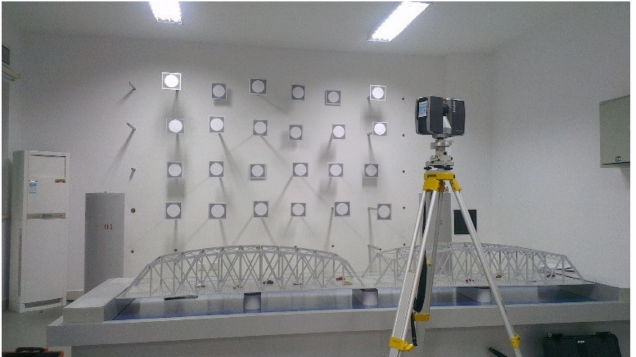
Figure 4. Rigorous calibration